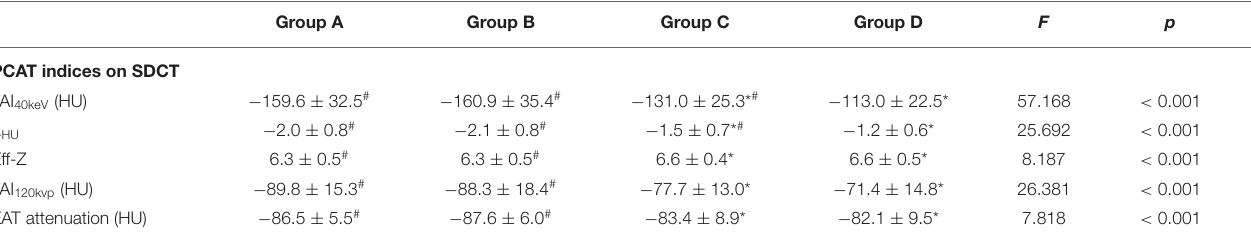
TABLE 3 | SDCT-related parameters of PCAT and EAT attenuation in different degree of stenosis groups.